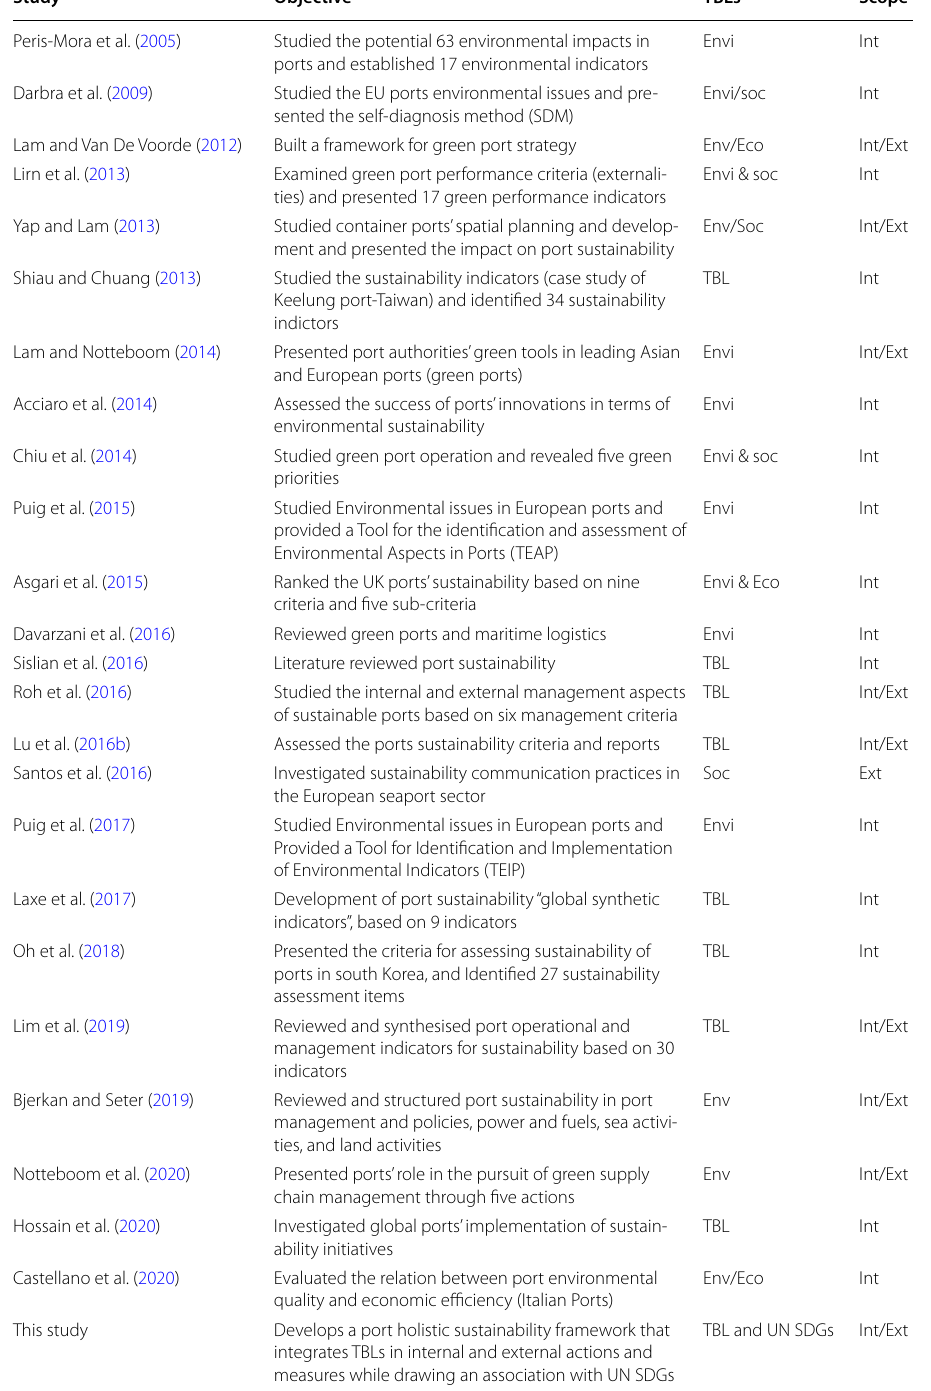
Table 2 Port sustainability studies, TBLs dimensions, and